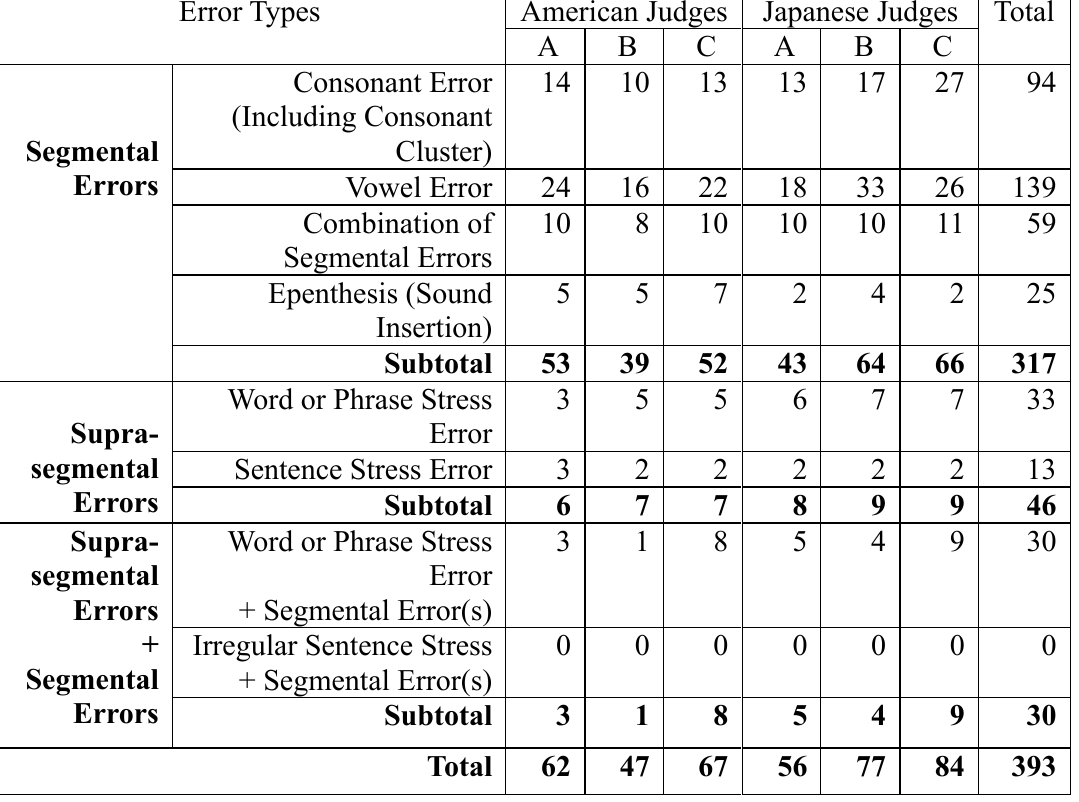
American Judges Japanese Judges Error